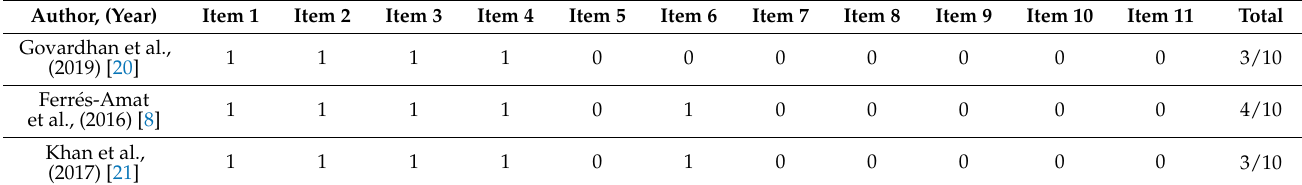
Table 5. Quality of the Case Studies, as measured by the SCED Scale.